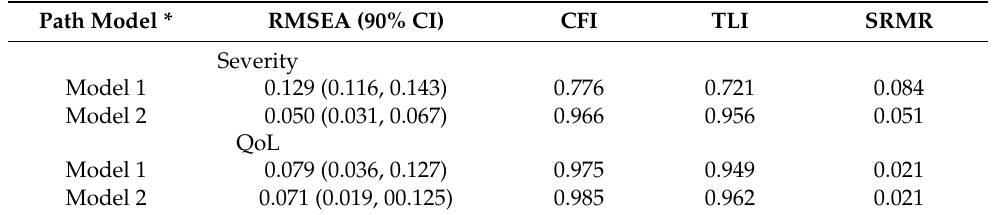
Table 3. Summary for Bloating Quality of Life in the Malay language (BLQoL)-M model fit indices ( n = 323).